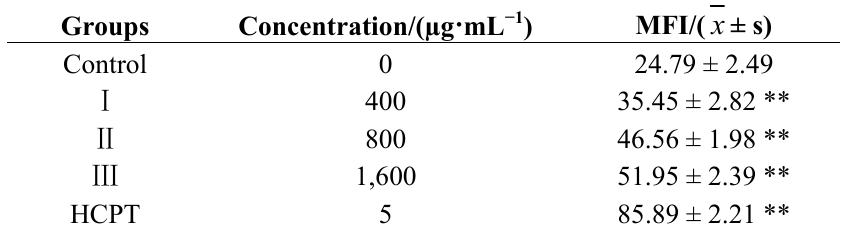
Table 2. Effects of laminarin on intracellular [Ca 2+ ] in